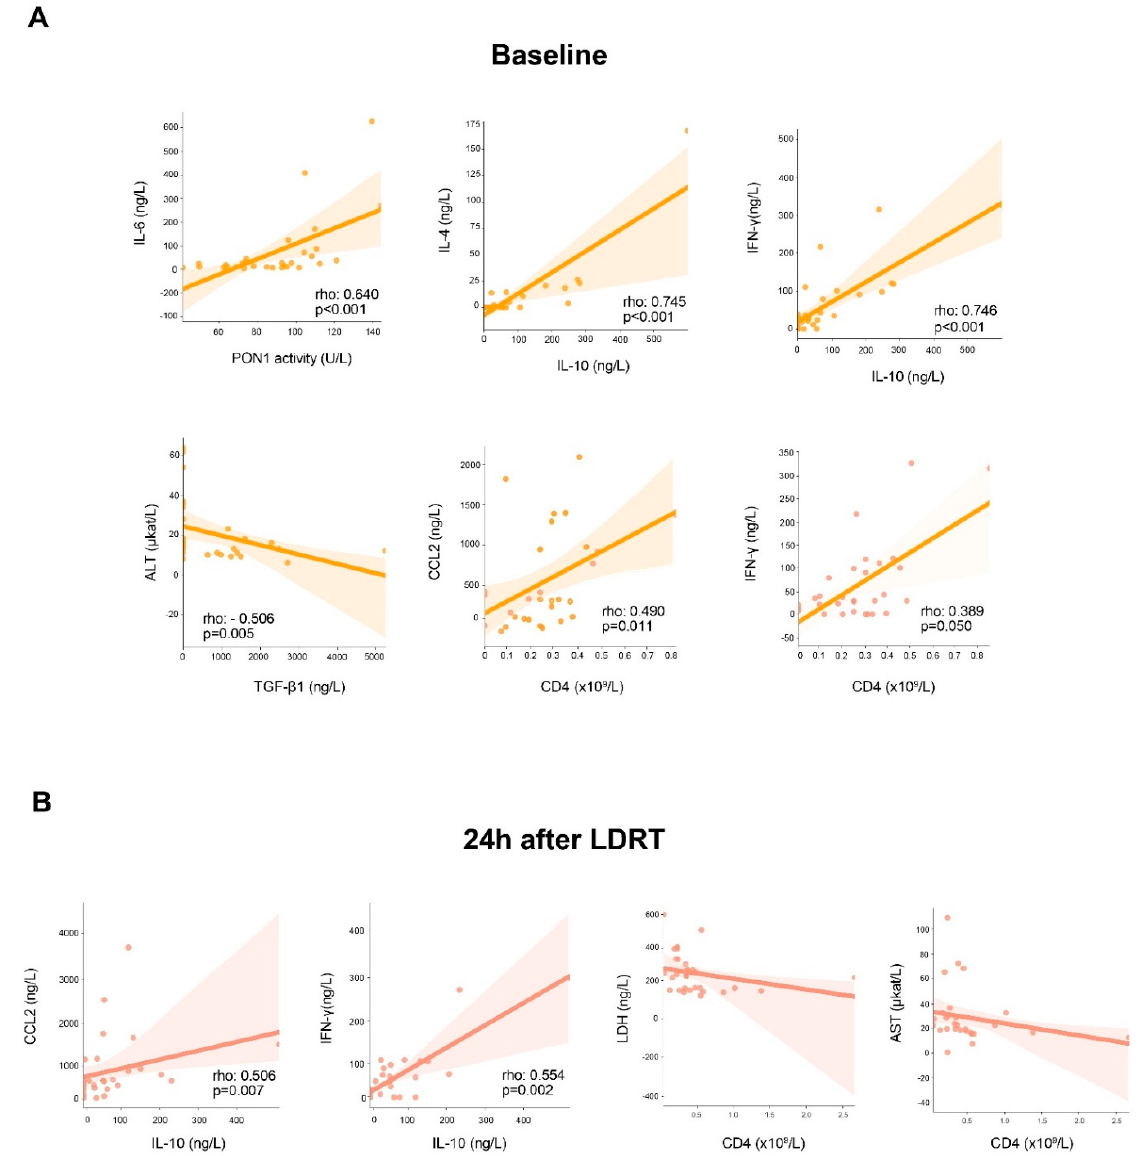
Figure 2. Statistically significant correlations between the analyzed variables at baseline and at 24 h after low-dose radiation therapy (LDRT). Abbreviations: ALT, alanine aminotransferase; CD, cluster of differentiation; IFN- γ , interferon γ ; IL, interleukin; LDH, lactate dehydrogenase; PON1, paraoxonase-1; TGF- β 1, transforming growth factor beta 1.